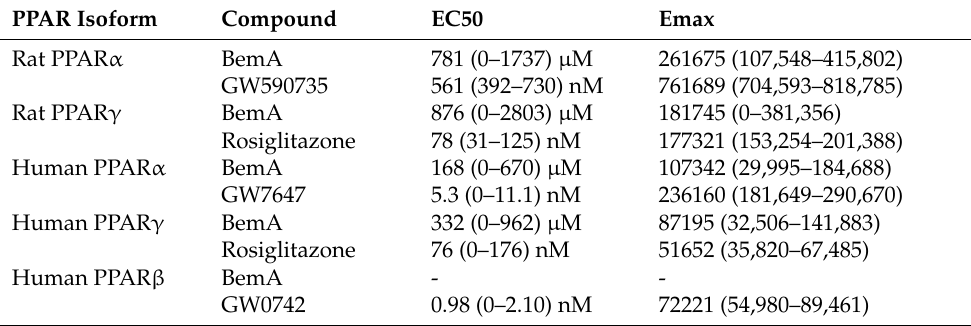
EC50: Half maximal effective concentration; Emax: Maximal effect. Values and 95% confidence intervals were calculated from the concentration-response curves via non-linear curve fitting by using the STATGRAPHICS Centurion software, version